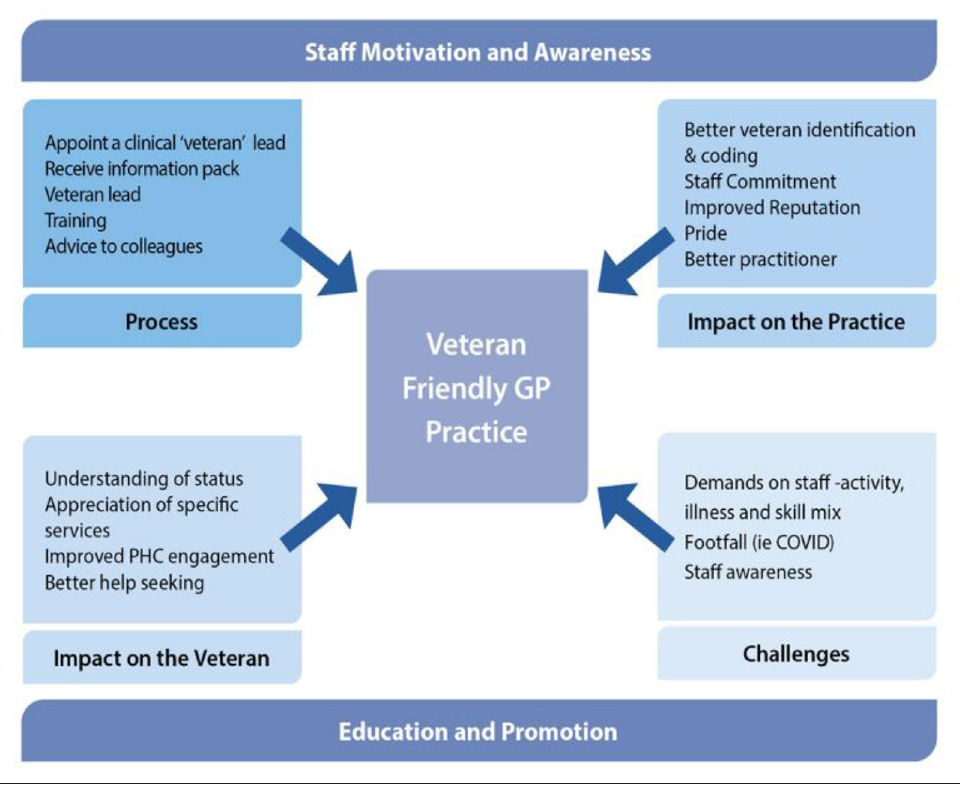
Figure 1 Factors influencing accreditation and outcomes of the programme. PHC = primary health